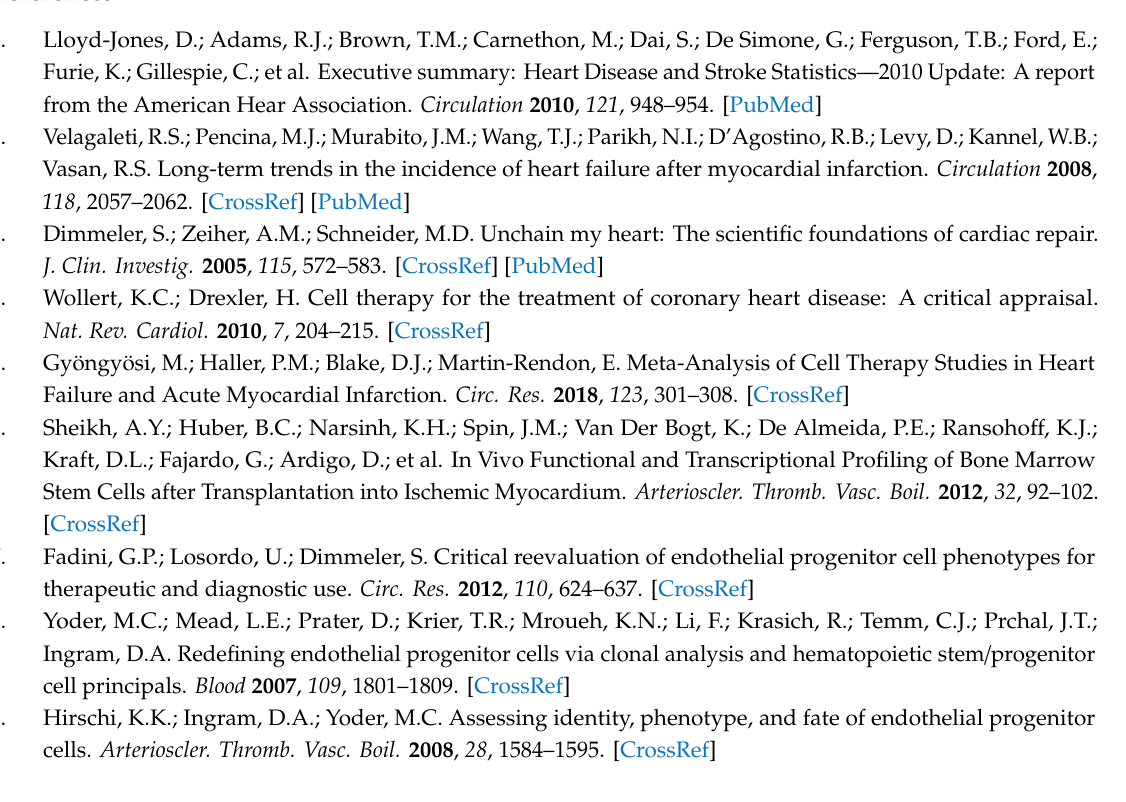
Figure S1: ECFC expression of proangiogenic transcription factors in vitro assessed by